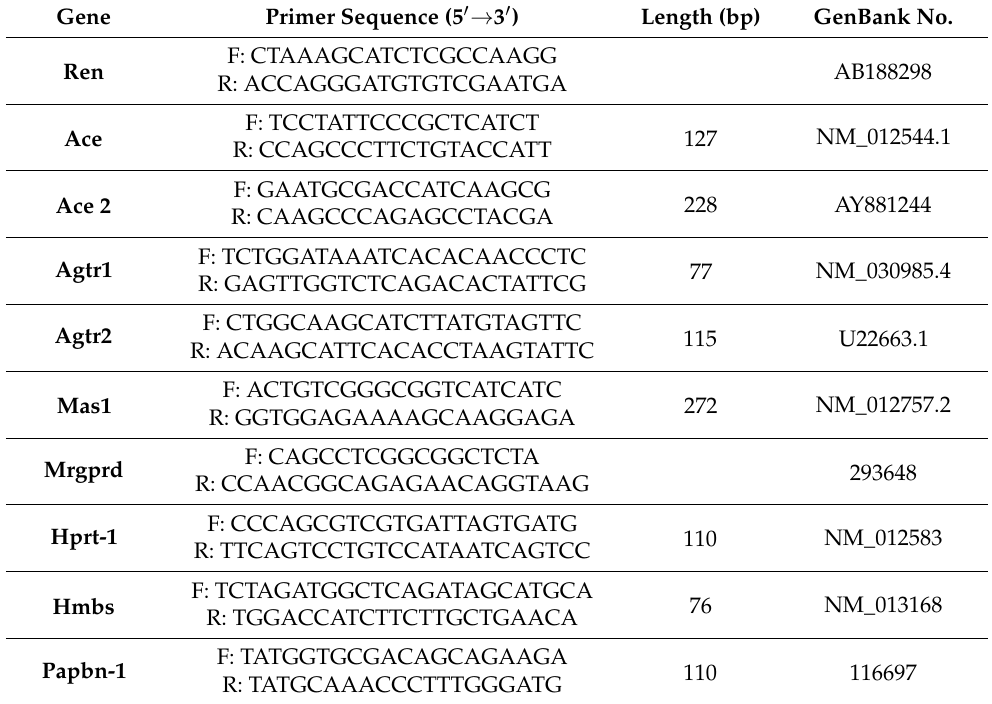
Table 2. Reference and target genes: primer